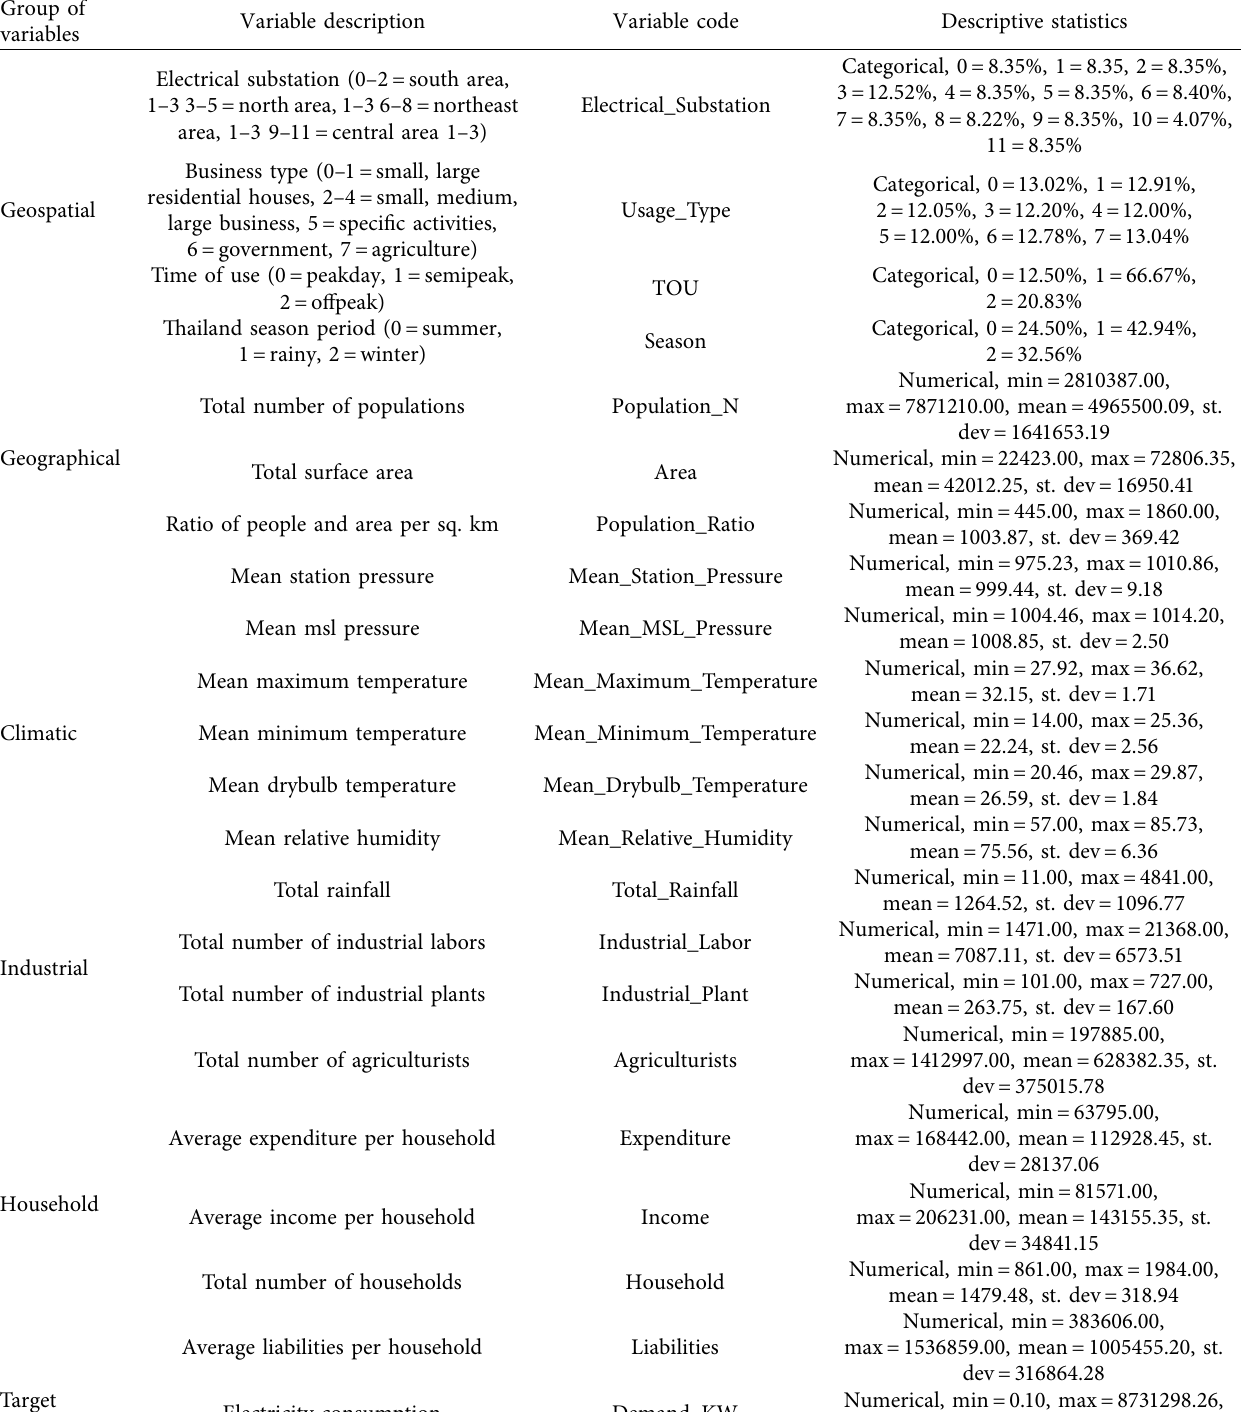
Table 1: Descriptive statistics of variables for the electricity consumption